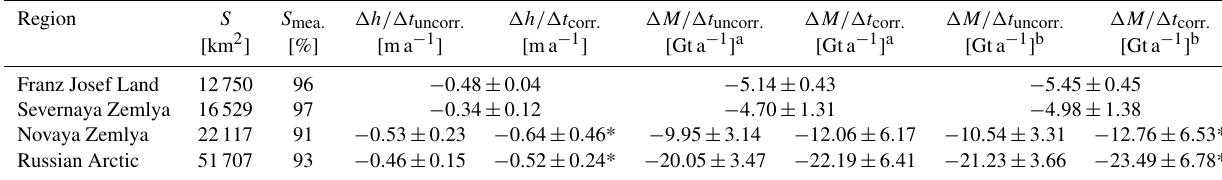
Table 1. Overview of glacier elevation and mass change in the Russian Arctic between 2010/11 and 2016/17. Glacier areas ( S ) are derived from the Randolph Glacier Inventory 6.0. Its spatial coverage by elevation change measurements ( S mea . ) is stated in percent; (cid:49)h/(cid:49)t uncorr . shows elevation change rates as measured by TanDEM-X, while (cid:49)h/(cid:49)t corr . includes the SAR signal-penetration-corrected elevation change rate of Novaya Zemlya. (cid:49)M/(cid:49)t uncorr . and (cid:49)M/(cid:49)t corr . are the respective glacier mass change rates using a volume-to-mass conversion factor of a 850kgm − 3 and b 900kgm − 3